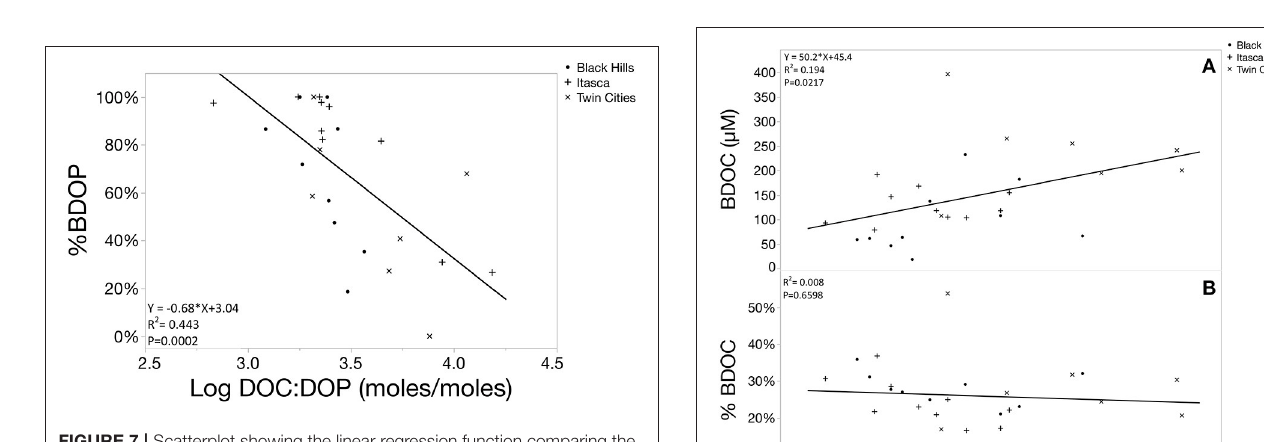
FIGURE 7 | Scatterplot showing the linear regression function comparing the percentage of BDOP to the DOC:DOP ratio of the initial sample (log transformed). The significant negative relationship demonstrates that the relative bioavailability of the DOP pool decreases as DOP becomes scarce relative to DOC.